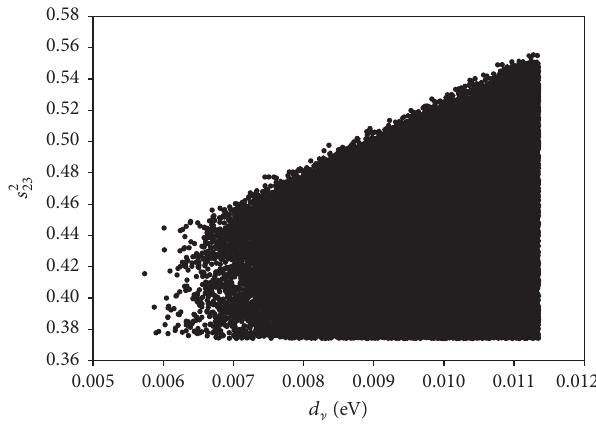
Figure 7: 𝛿 𝑙 versus 𝑓 󸀠 𝑙 for Case B.